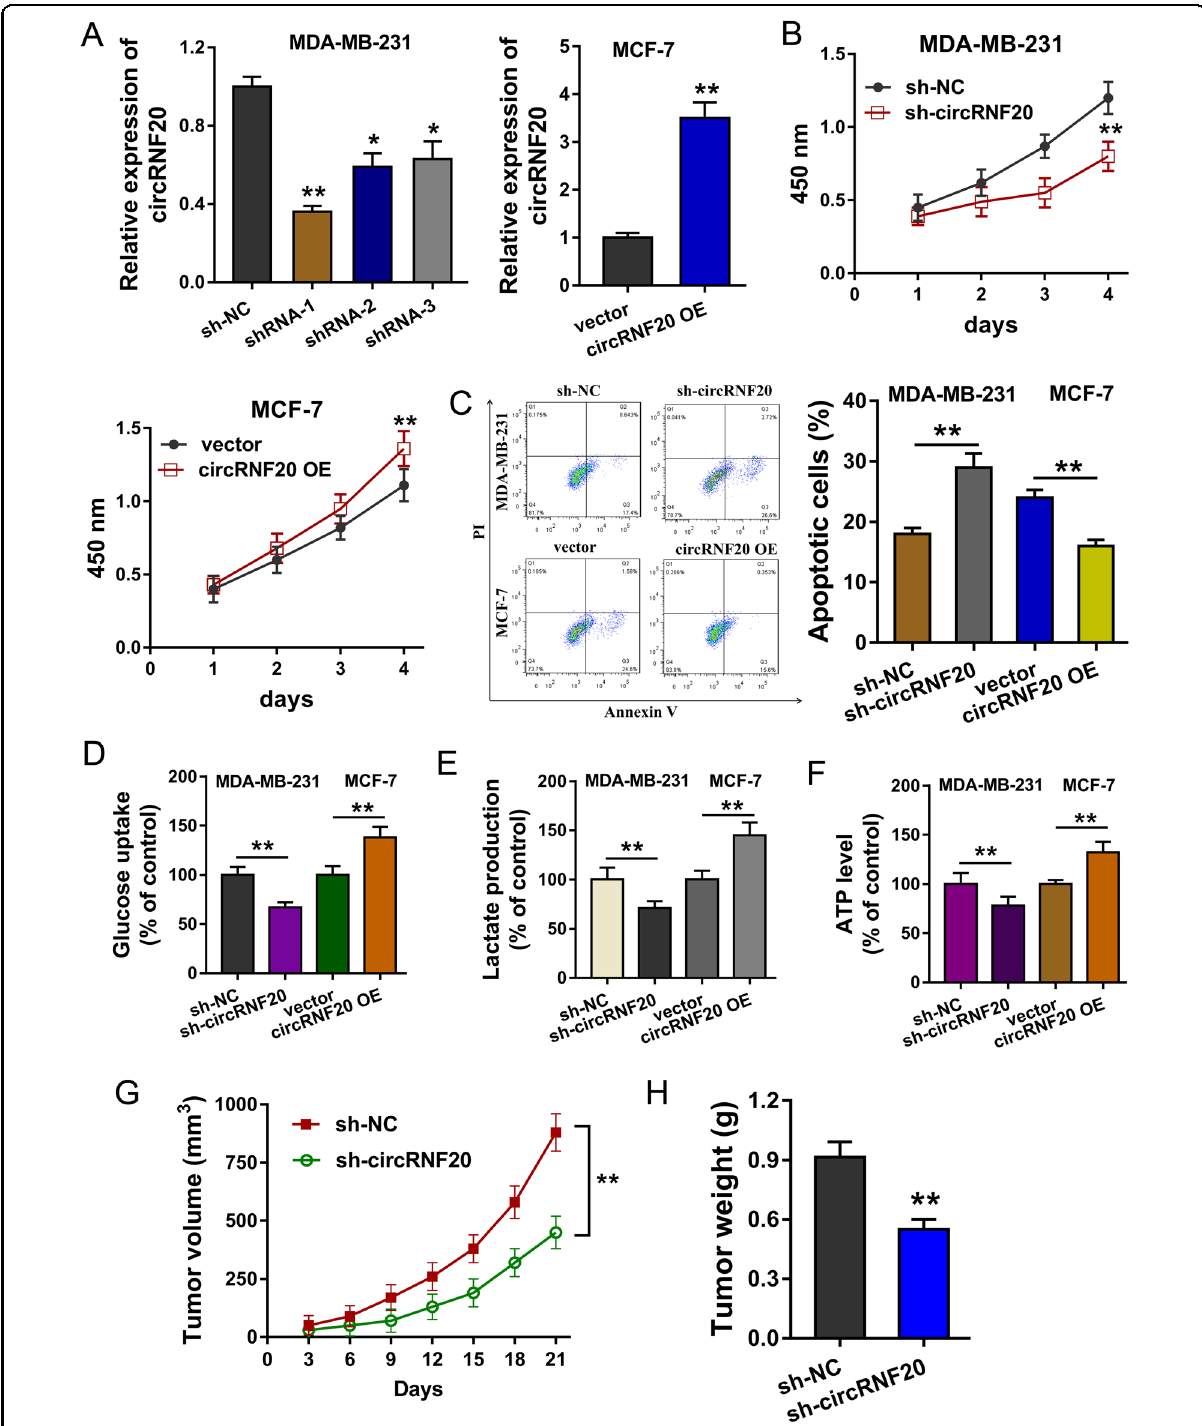
Fig. 2 circRNF20 promotes the progress and glycolysis of BC. a Stable oligonucleotides transfections were constructed, including circRNF20 knockdown (sh-circRNF20) in MDA-MB-231 cells and circRNF20 overexpression (circRNF20 OE) in MCF-7 cells. b CCK-8 proliferative assay showed the proliferation with the transfection of circRNF20 knockdown and circRNF20 overexpression. c Flow cytometry apoptosis assay indicated the apoptotic rate of MDA-MB-231 and MCF-7 cells. d Relative glucose uptake was detected in BC cells. e Relative lactate production was detected in BC cells. f Relative ATP level was detected in BC cells. g , h In vivo mice heterograft assay unveiled the tumor growth in mice injection using MDA-MB-231 cells transfected with circRNF20 knockdown. ** p < 0.01 vs. control. * p < 0.05 vs.